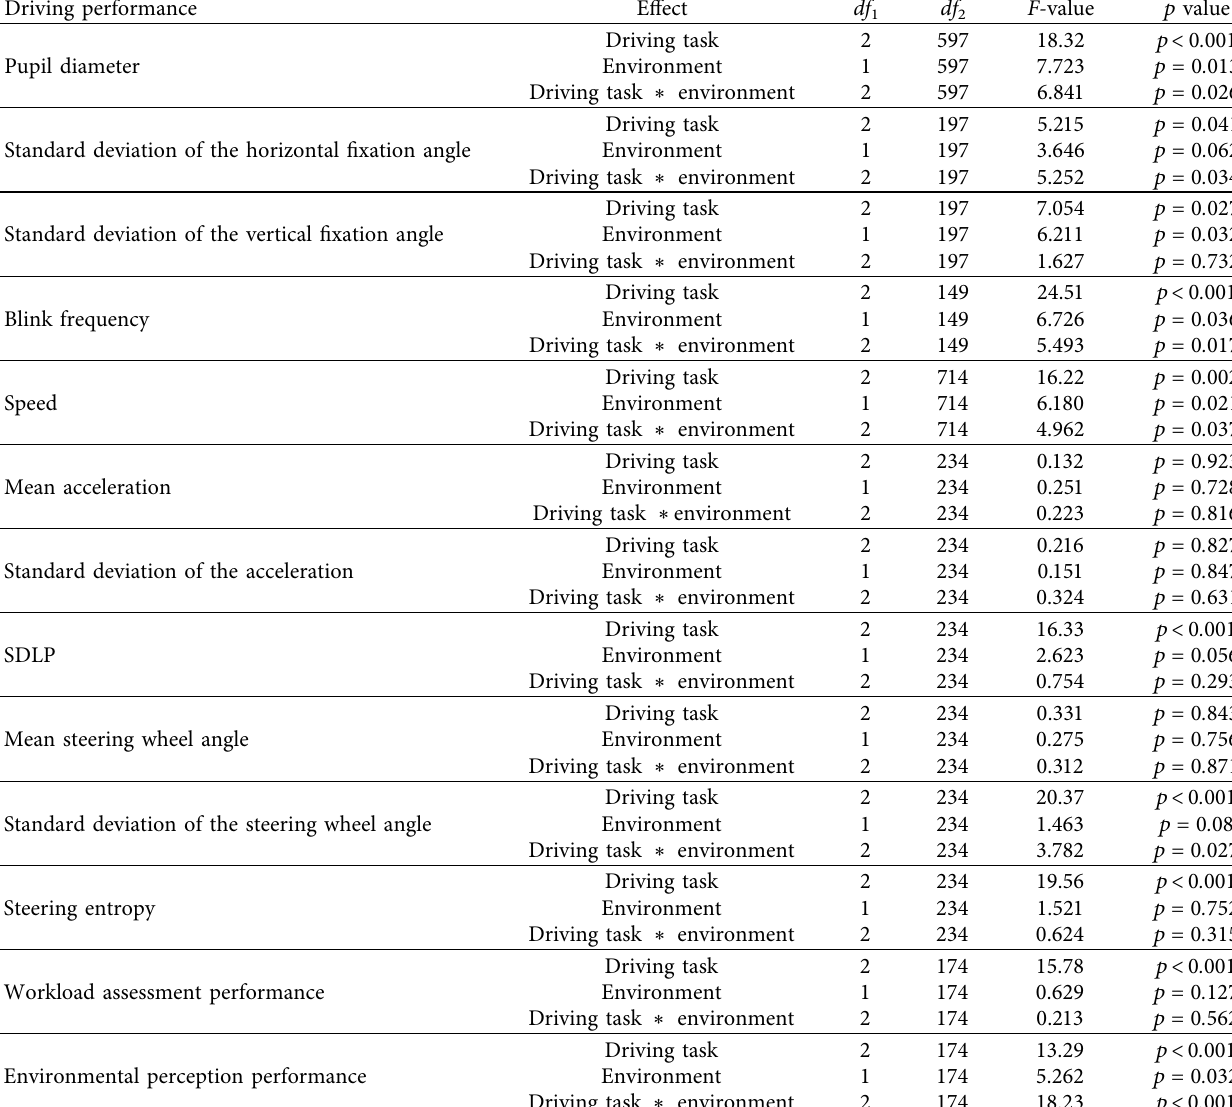
Table 2: ANOVA tests on all